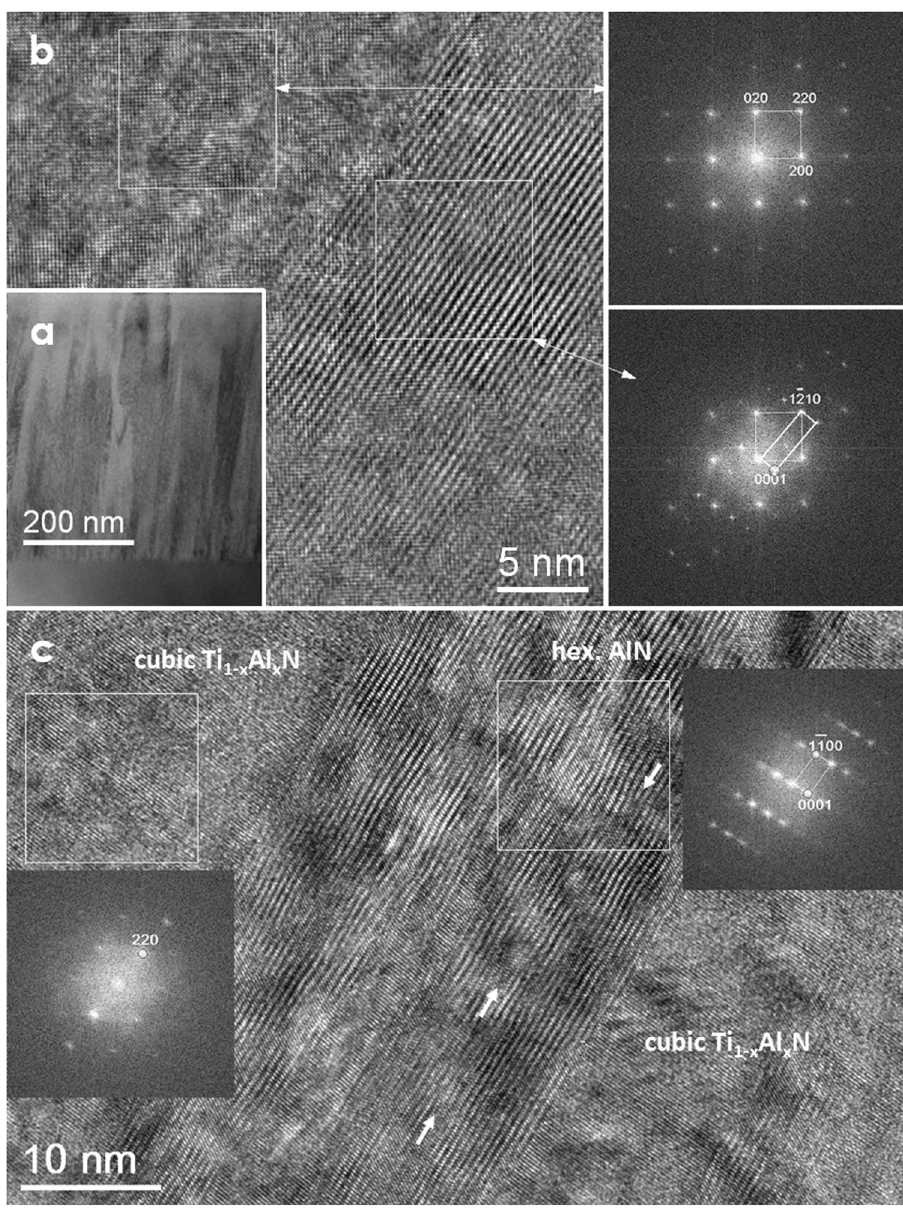
Figure 2. ( a ) Low magnification TEM image showing the columnar morphology of Ti 1 − x Al x N; ( b ) HRTEM image covering one cubic Ti 1 − x Al x N grain along the [001] zone axis and hexagonal AlN grains along the [2110] direction, the corresponding FFTs are attached; ( c ) HRTEM image showing one hexagonal AlN grain that grows in between two cubic Ti 1 − x Al x N grains, viewing direction of AlN is close to hexagonal [1120] . Multiple stacking faults and nano-twins in the hexagonal AlN phase are visible. One stacking fault is exemplarily marked with white arrows (pointing to the locations of partial dislocations). Note that all FFTs are obtained from the square